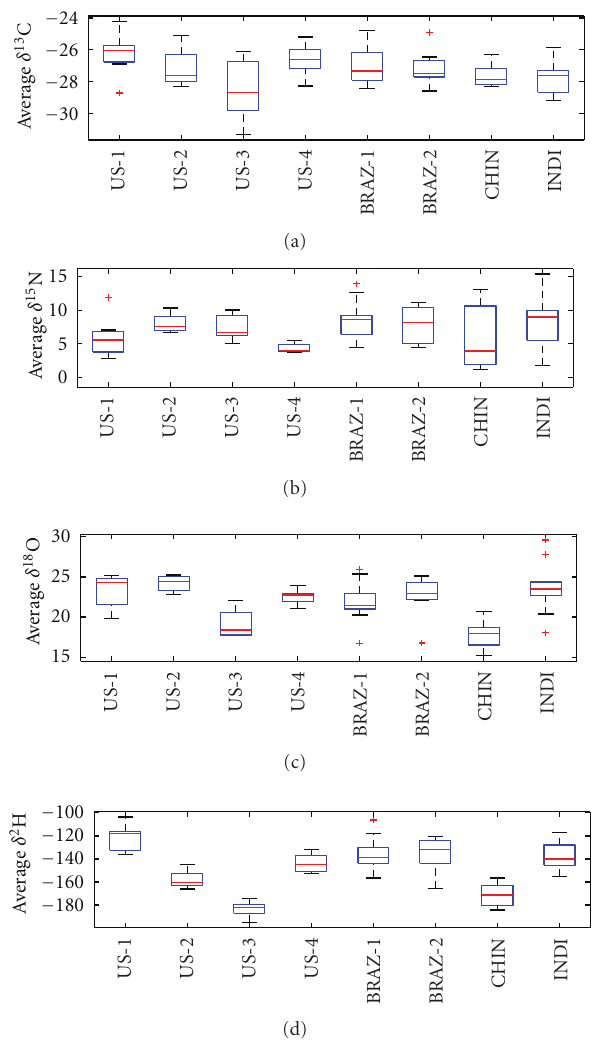
Figure 2: Boxplots showing the spread and deviation within each region for each light element IR.